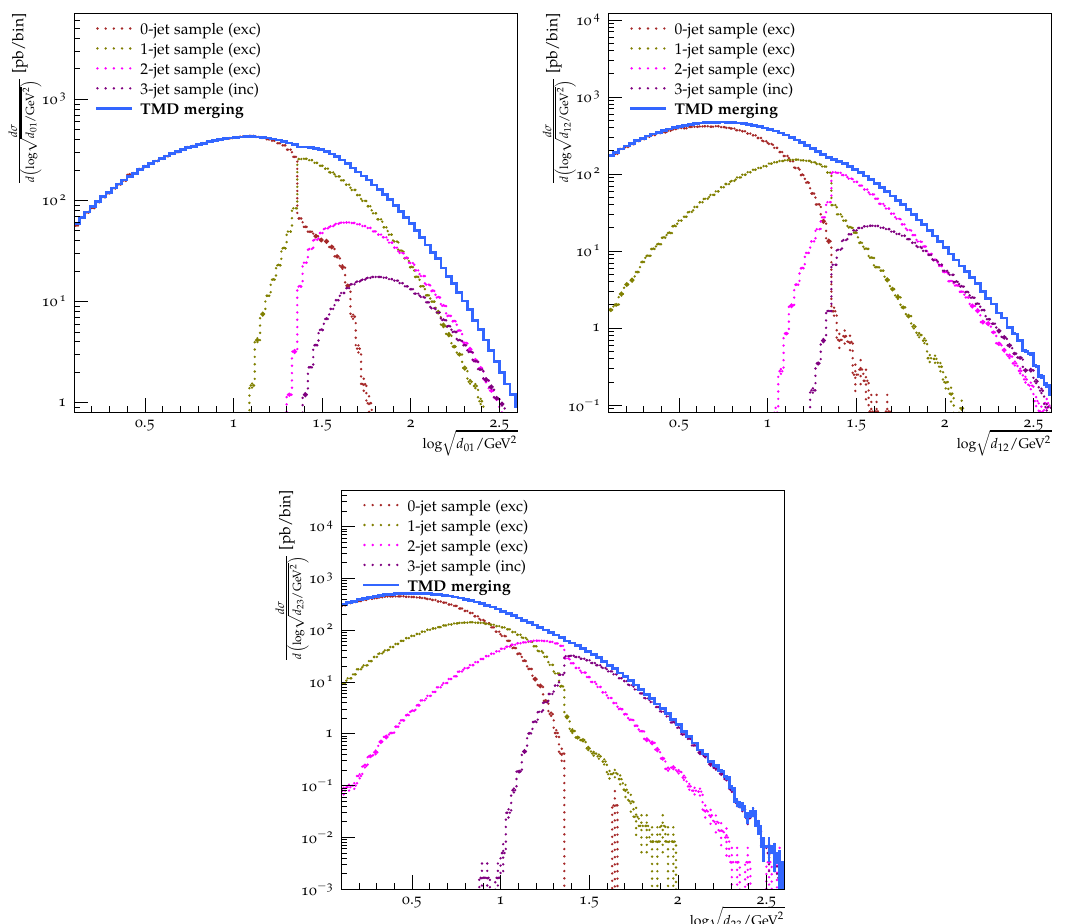
Figure 8 . The d n,n +1 spectra for n = 0 , 1 , 2 at parton level, where d n,n +1 represents the energy- square scale at which an ( n + 1) -jet event is resolved as an n -jet event in the k algorithm. The dotted curves represent the contributions of the single-multiplicity samples while the solid curve corresponds to their sum. For each panel all jet multiplicities are obtained in exclusive (exc) mode except for the highest multiplicity which is calculated in inclusive (inc)